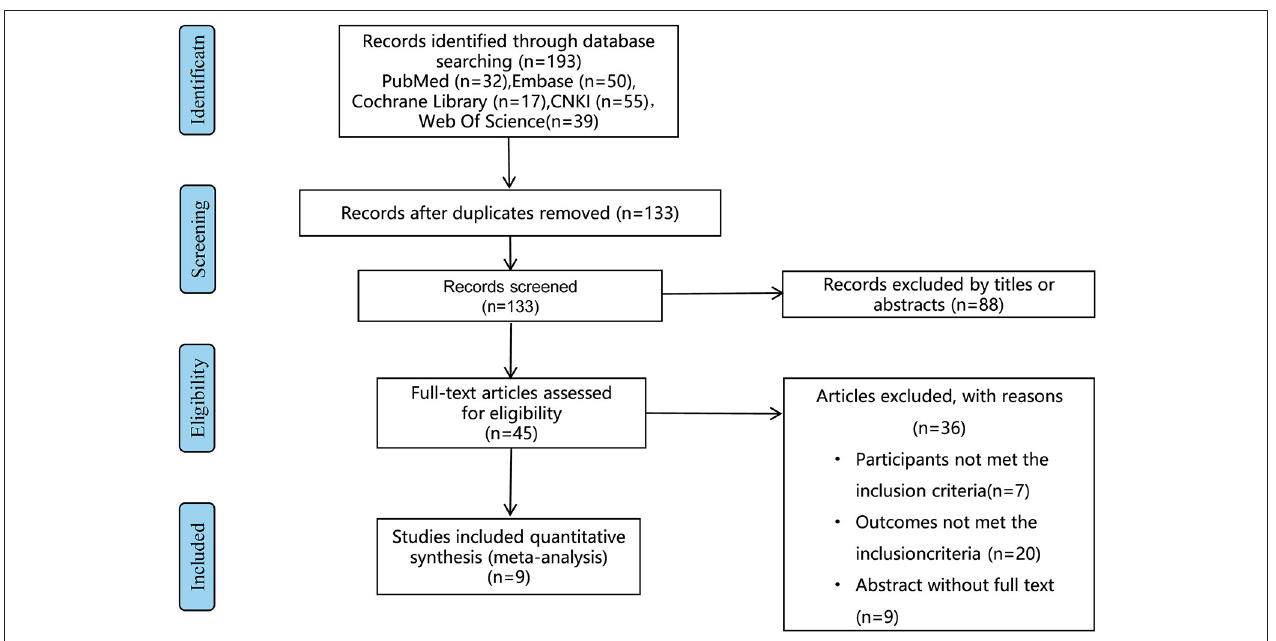
FIGURE 1 | The PRISMA flow diagram for the study selection process. based on the included and excluded criteria, nine studies were included